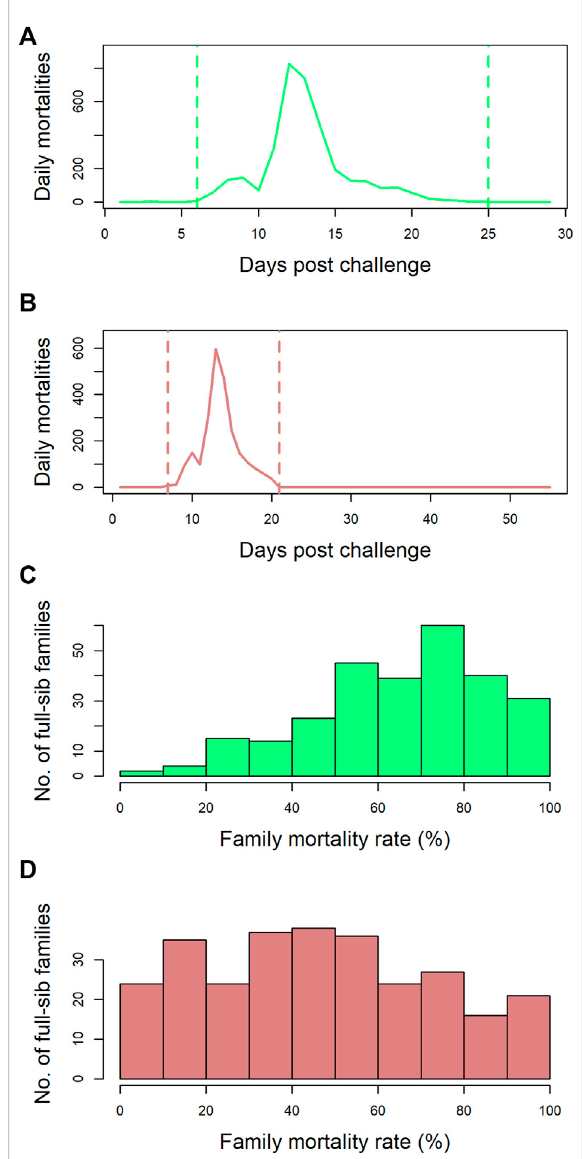
FIGURE 1 Mortality rate pro fi les of the datasets: (A) the number of mortalities observed per day over the course of the challenge trial (29 days) for dataset-1. Mortalities started 5 days post challenge and ended 25 days post challenge with the peak mortality observed at 12 days post challenge. (B) the number of mortalities observed per day over the course of the challenge trial (56 days) for dataset-2. Mortalities started 7 days post challenge and ended 21 days postchallengewith thepeakmortality observed at13 days post challenge. (C) dataset-1 — the number of full-sib families across the 273 full-sib families with a given percentage mortality. The mortality rate ranged from 0% to 100%, with an average mortalityrateof67%. (D) dataset-2 — thenumberoffull-sibfamilies across the 282 full-sib families with a given percentage mortality. The mortality rate ranged from 0% to 100%, with an average mortality rate of